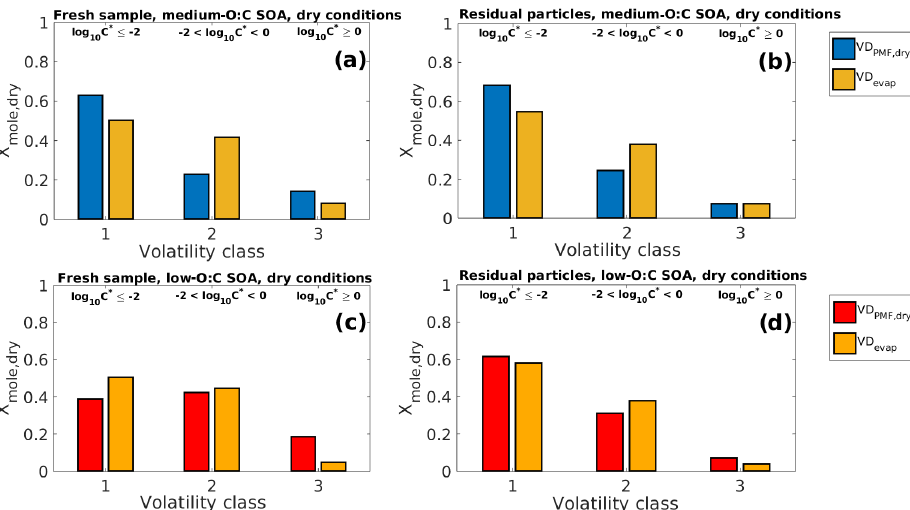
Figure 7. Comparison of VD PMF , dry (volatility distribution with C ∗ calculated from the peak desorption temperature, T max , of each PMF factor) and VD evap (volatility distribution determined by fitting the LLEVAP model to the measured evapogram) at the mean evaporation time of the SOA samples in dry-condition experiments. The VD bins are grouped into three volatility classes, similar to Fig. 3. The limits for each volatility class are shown at the top and are the same for each subfigure. (a) Fresh sample of medium-O : C SOA. (b) Residual particles of medium-O : C SOA after 170–256min of evaporation (the RTC sample). (c) Fresh sample of low-O : C SOA. (d) Residual particles of low-O : C SOA after 152–238min of evaporation (the RTC sample). The VD PMF , dry shows lower overall volatility than the VD evap for medium-O : C SOA. For low-O : C SOA, the VD PMF , dry shows higher volatility for the fresh sample and similar volatility compared to the VD evap after 152–238min of evaporation.